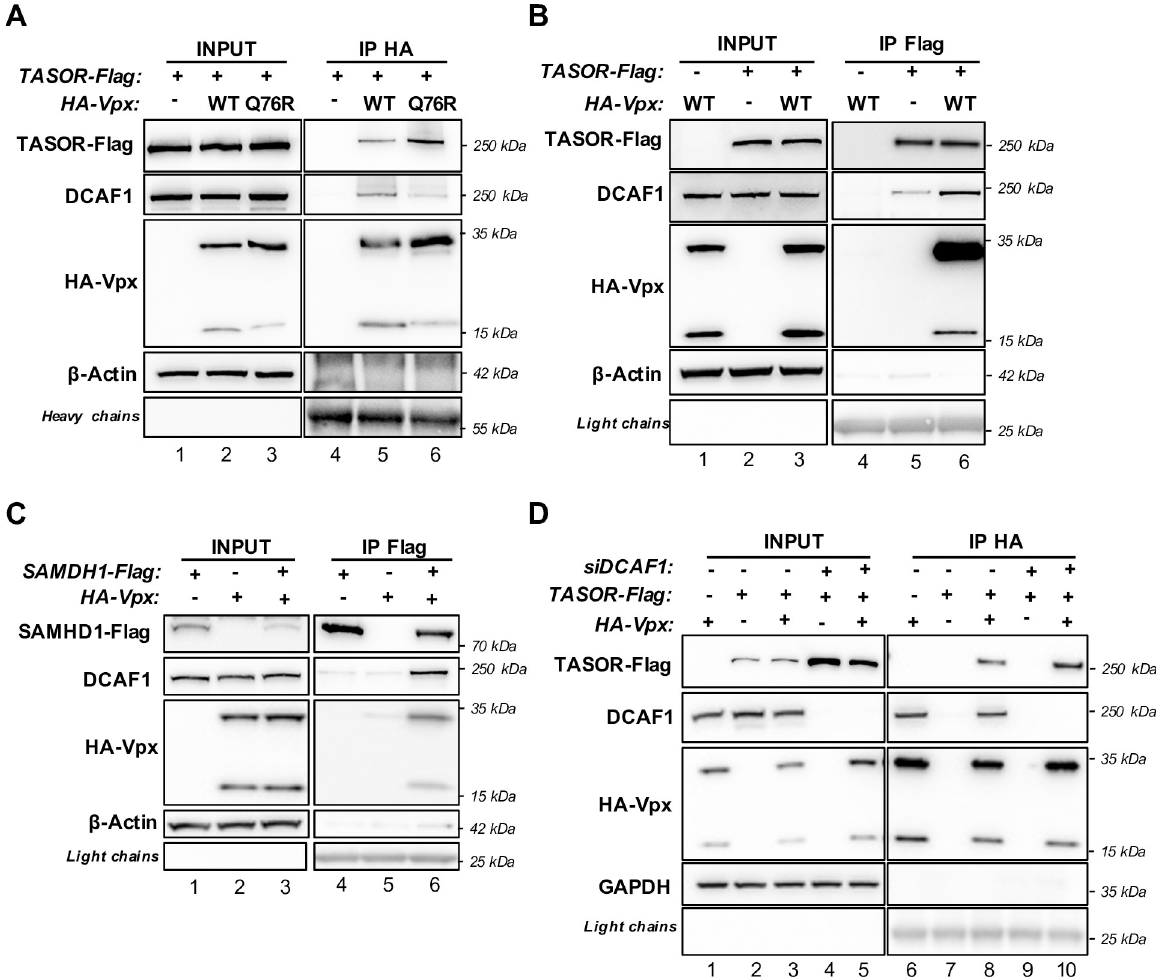
Fig 1. Interaction between TASOR and DCAF1 is stabilized in the presence of Vpx. ( A ) HA-Vpx WT or DCAF1 binding-deficient HA-Vpx Q76R proteins were co-expressed with TASOR-Flag in HeLa cells, then an anti-HA immunoprecipitation was performed. ( B ) TASOR-Flag and HA-Vpx WT were co-expressed in HeLa cells, then an anti-Flag immunoprecipitation was performed. ( C ) SAMHD1-Flag and HA-Vpx WT were co-expressed in HeLa cells, then an anti-Flag immunoprecipitation was performed. ( D ) HeLa cells were treated with either siRNA CTL or siRNA DCAF1. After 24h, HA-Vpx WT and TASOR-Flag were co-expressed for 48h, then an anti-HA immunoprecipitation was performed. In each panel, the indicated proteins were revealed by western blot. For this figure, each shown immunoblot is representative of at least 3 independent